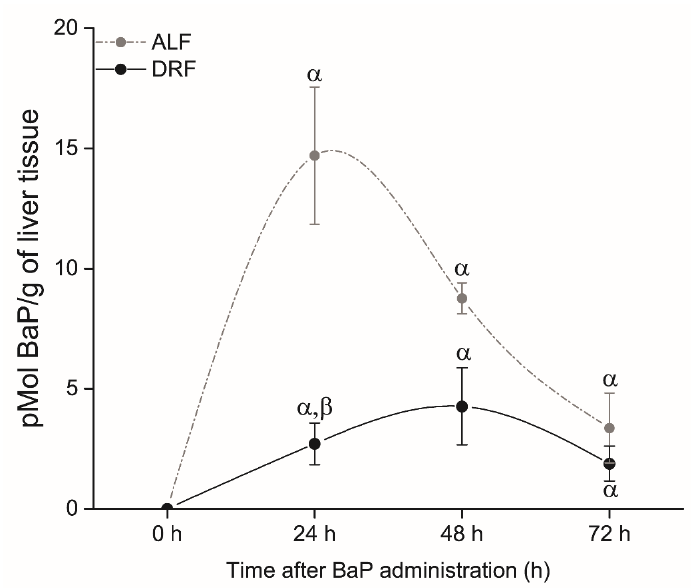
Figure 5. Retention of unmetabolized BaP in the liver of rats with ALF (gray circles) and DRF (black circles) after BaP administration at 10 mg/kg. Each point corresponds to the mean ± SEM, n = 6. α p ≤ 0.05 compared to the control group fed with the same diet (DRF at ZT1 and ALF at ZT13) and β p ≤ 0.05 compared to the ALF group at the same time point.